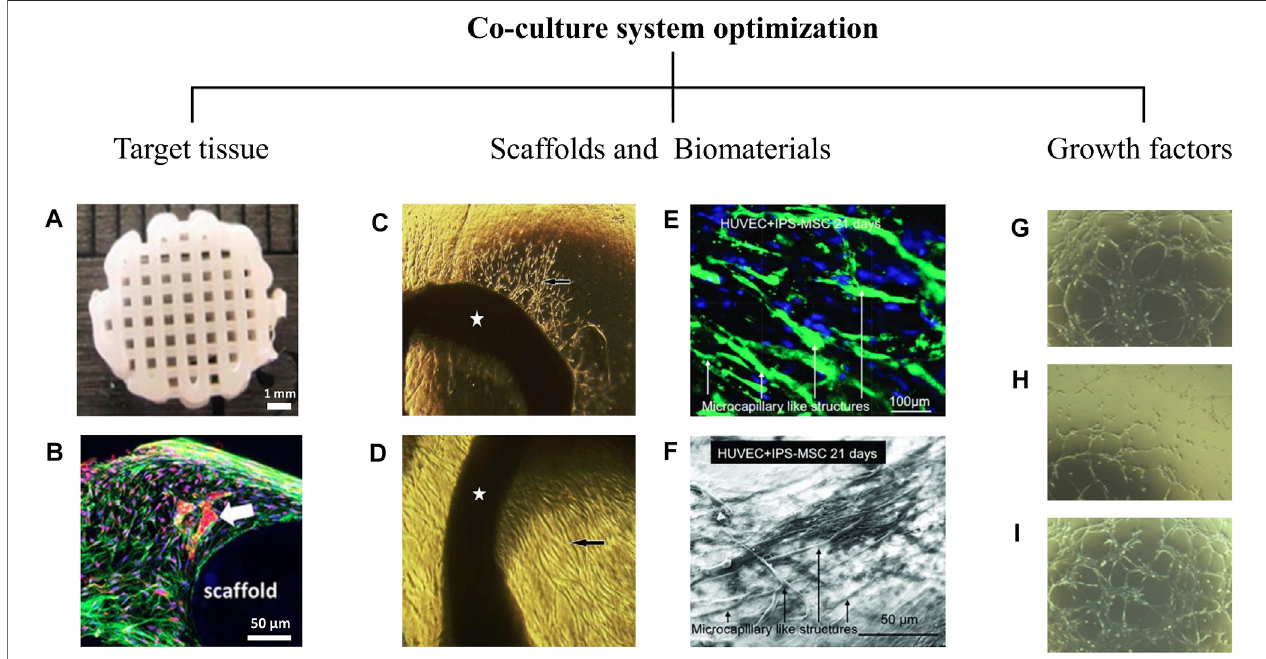
FIGURE 2 | Co-culture system optimization. Co-culture system optimization depends on critical factors that profoundly alter cell behaviors. Target tissue is a decisivefactor inthevascularizationprocess. Thecellularmicroenvironment isanothercriticalfactor thatin fl uencesprevascularization.Asshown inthe (A,B) ,co-culture of AD-MSCs (Adipose tissue derived mesenchymal stem cells) and HUVECs (Human umbilical vein endothelial cells) in a 3D printed polycaprolactone/hydroxyapatite scaffold coated with cell-laden hydrogels leads to the formation of an appropriate capillary network (white arrow) at day 21 (Kuss et al., 2018). It is evident that topographical and physicochemical properties and even the type of biomaterial used in scaffolds affect prevascularization. (C,D) Aortic rings (pointed by stars) cultured on the mesenchymal side (C) and epithelial side (D) of a decellularized amniotic membrane developed in our laboratory. After 7 days of culture, capillary-like structures and endothelial-like penetrations (black arrows) have been identi fi ed on both sides of the amniotic membrane (original magni fi cation X40) (Niknejad et al., 2013). (E,F) HUVECs and hiPSC-MSC (human induced pluripotent stem cell derived mesenchymal stem cells) co-culture on a calcium phosphate cement (CPC) scaffold. Microcapillaryformationswasformedatday21(Liuetal.,2017).Theprevascularizationprocessisalsoin fl uencedbygrowthfactorsusedincellculturemedia. (G – I) The formationofcord-like structures byendothelialcellsinresponsetoFGF2 (G) , VEGF (H) ,and thecombinationofboth (I) has shown atday 10(original magni fi cation X20) (Khan et al.,